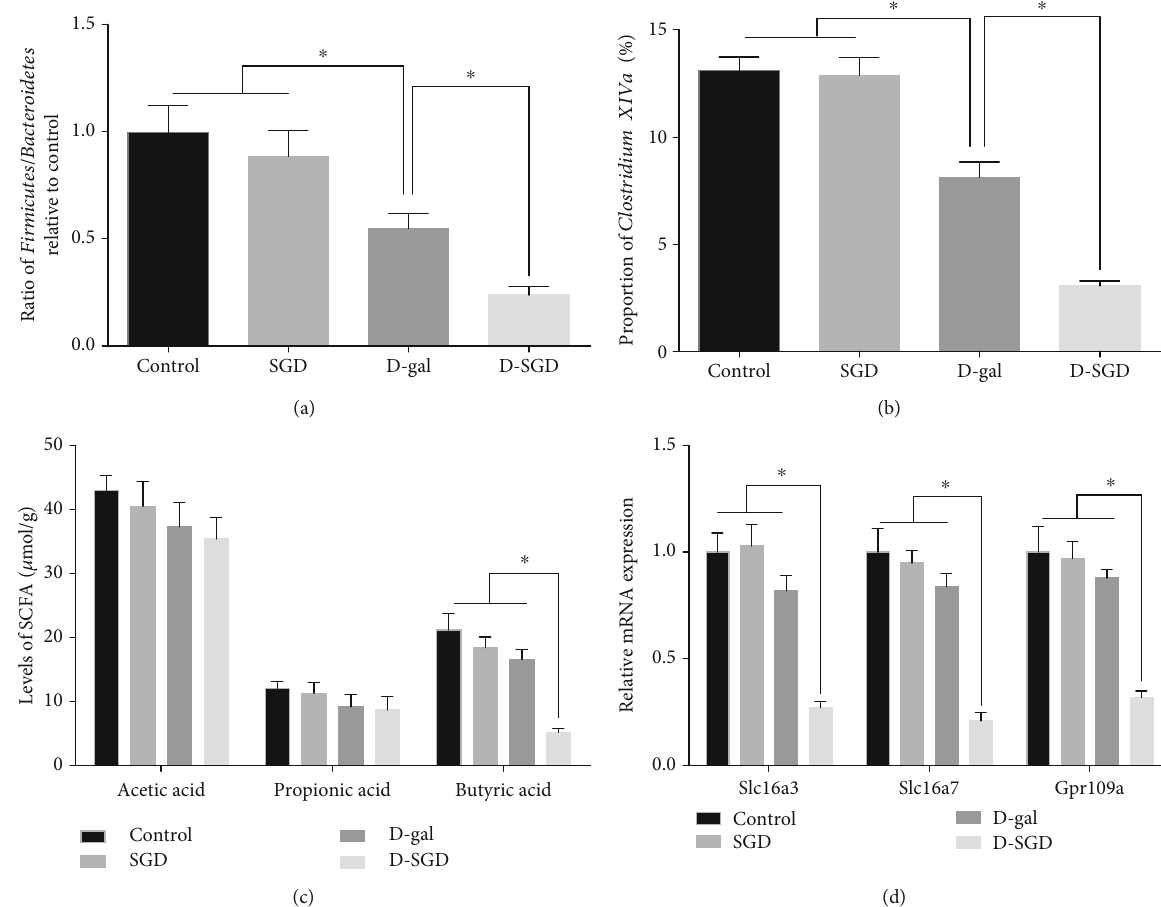
Figure 2: Serine de fi ciency exacerbated structure change of microbiota and decreased SCFA levels in D-galactose-treated mice. (a) Ratio of Firmicutes / Bacteroidetes in fecal microbiota; (b) proportion of Clostridium XIVa ; (c) levels of short-chain fatty acids (SCFA) in feces; (d) relative mRNA expression of Slc16a3 , Slc16a7 , and Gpr109a in the brain. Data were expressed as mean ± SEM , n = 8 . ∗ P < 0 : 05 .